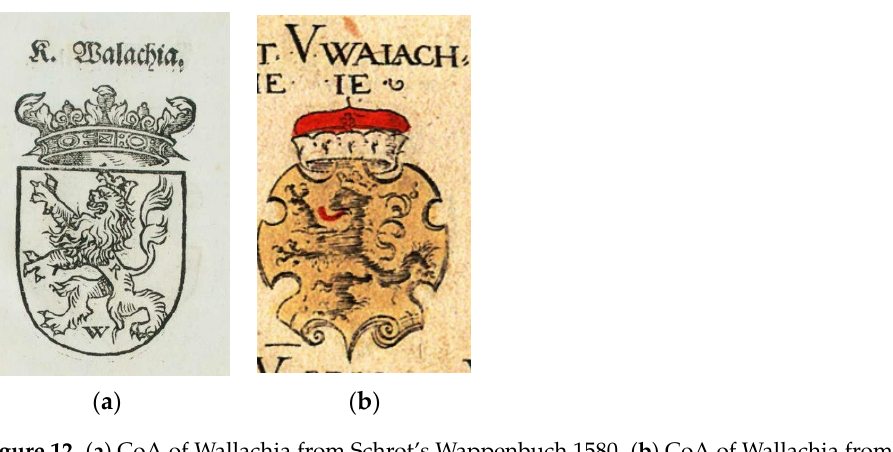
Figure 12. ( a ) CoA of Wallachia from Schrot’s Wappenbuch 1580. ( b ) CoA of Wallachia from Solis’s Wappenbuchler 1555.